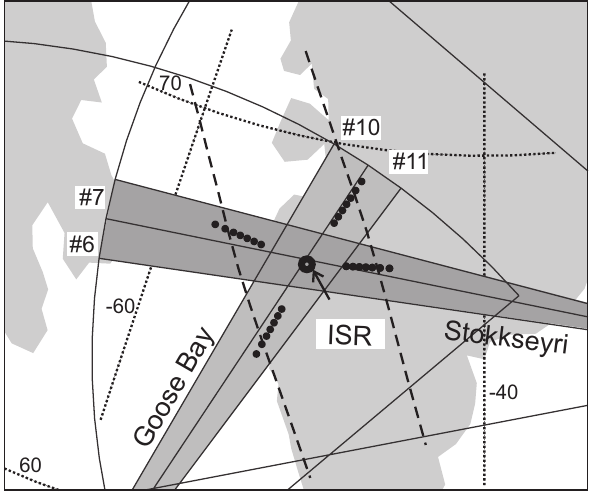
Fig. 4. A map showing the orientation of specific SuperDARN radar beams and the ISR. The closed circles indicate the Sondrestrom ISR range gates used for l-o-s velocity measurements from four specific beam positions that fall within one of four SuperDARN beams. Po- sitions of the Stokkseyri beams #6 and #7 and the Goose Bay radar beams #10 and #11 are only indicated; for these beams the Sondre- strom measurements were well aligned and within the central parts of them. Large open circle indicates the position of the Sondrestrom